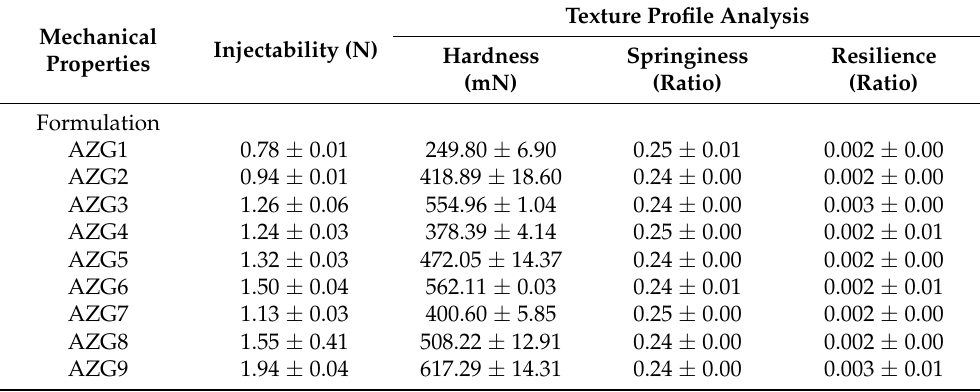
Table 3. Injectability and textural properties of AZG (mean ± SD, n =